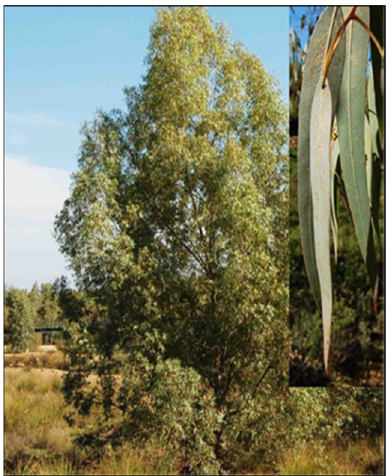
Figure 11. Eucalyptus camaldulensis